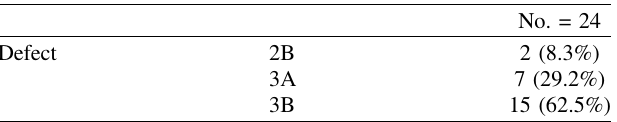
Table 1. Distribution of the studied cases according to acetabular defects.